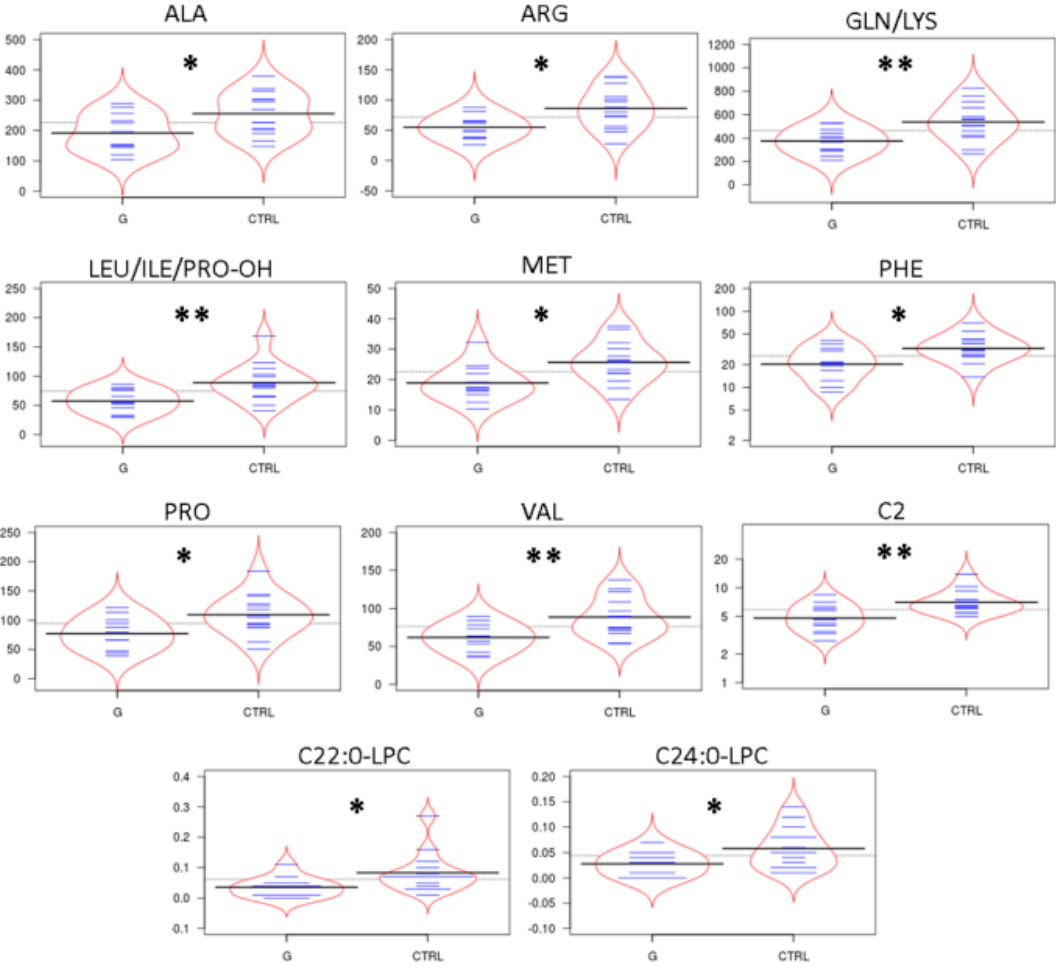
Figure 2. In Figure 2 we report the distribution of the significantly different amino acids (AAs), acylcarnitines (ACCs) and lysophosphatidylcholine (LPCs) in the comparison between tear samples from glaucoma patients (G) versus tear samples from CTRL, visualized as the beanplots. In these plots, the polygon shape (in red line) represents the density trace computed using a log-transformation of each variable, and inside to that, a scatter plot shows all individual measurements (blue lines). * means p < 0.05, ** means p < 0.01 at the Student’s t-test and/or Mann Whitney U -test.